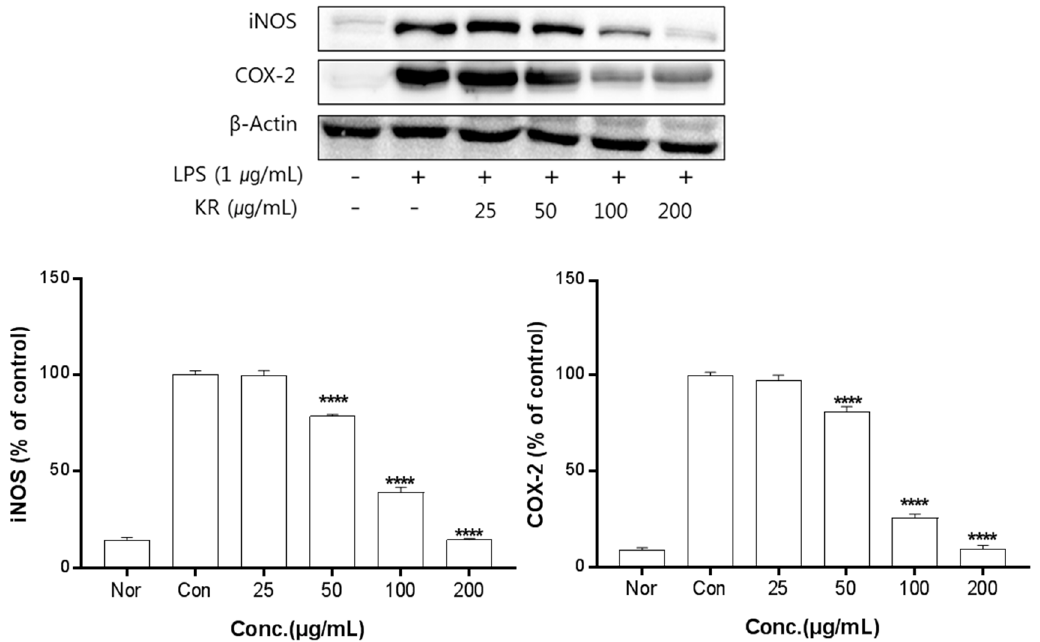
Figure 3. Inhibitory effects of KR on iNOS and COX-2 production in LPS-stimulated Raw 264.7 cells. Equal amounts of cell lysates (30 µ g) were subjected to electrophoresis and analysed for iNOS and COX-2 production by Western blot. Raw 264.7 cells were incubated with LPS (1 µ g/mL) and KR extract for 24 h. Each value is expressed as mean ± SD of three independent experiments. **** p < 0.0005 as analyzed by Duncan’s multiple range